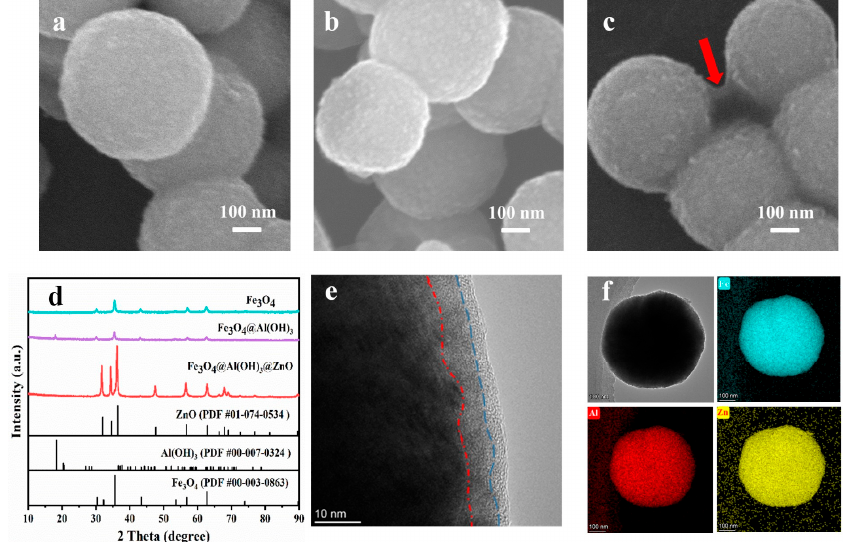
Figure 2. Basic characterization of various nanospheres. SEM images of the ( a ) Fe 3 O 4 , ( b ) Fe 3 O 4 @Al(OH) 3 , and ( c ) Fe 3 O 4 @Al(OH) 3 @ZnO nanospheres. ( d ) XRD patterns of various nanospheres. ( e ) TEM image of FAZ. ( f ) The element mappings of the Fe, Al and Zn.